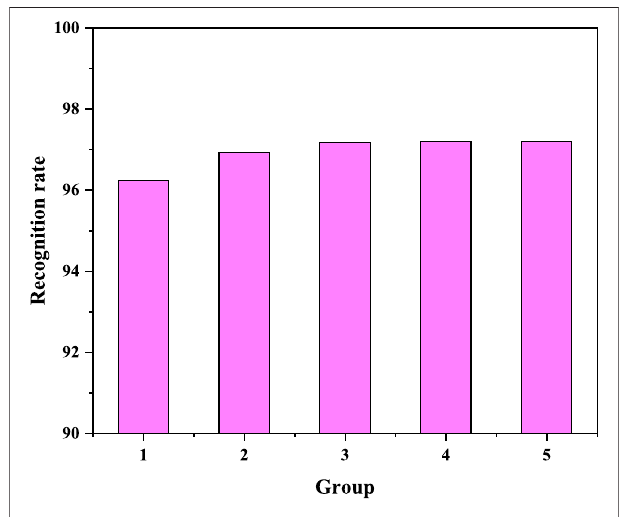
FIGURE 8 | Optimization results of genetic algorithm